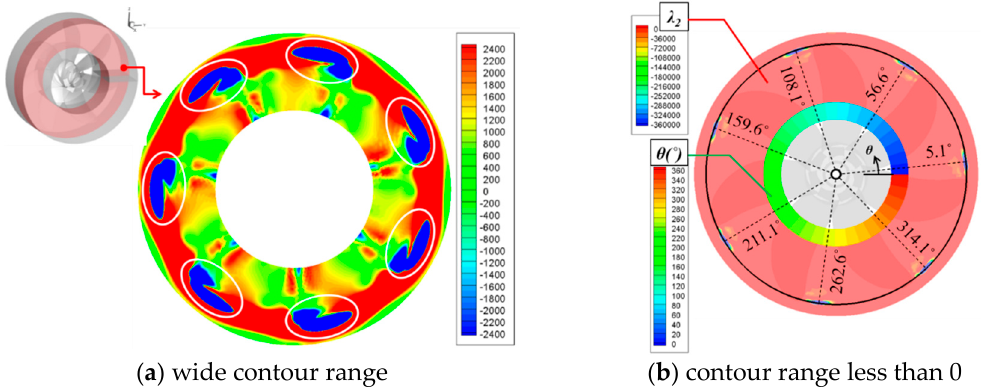
Figure 9. Distribution of λ 2 -contours ( a ) in a full wide range of λ 2 and ( b ) in a range of λ 2 less than 0.